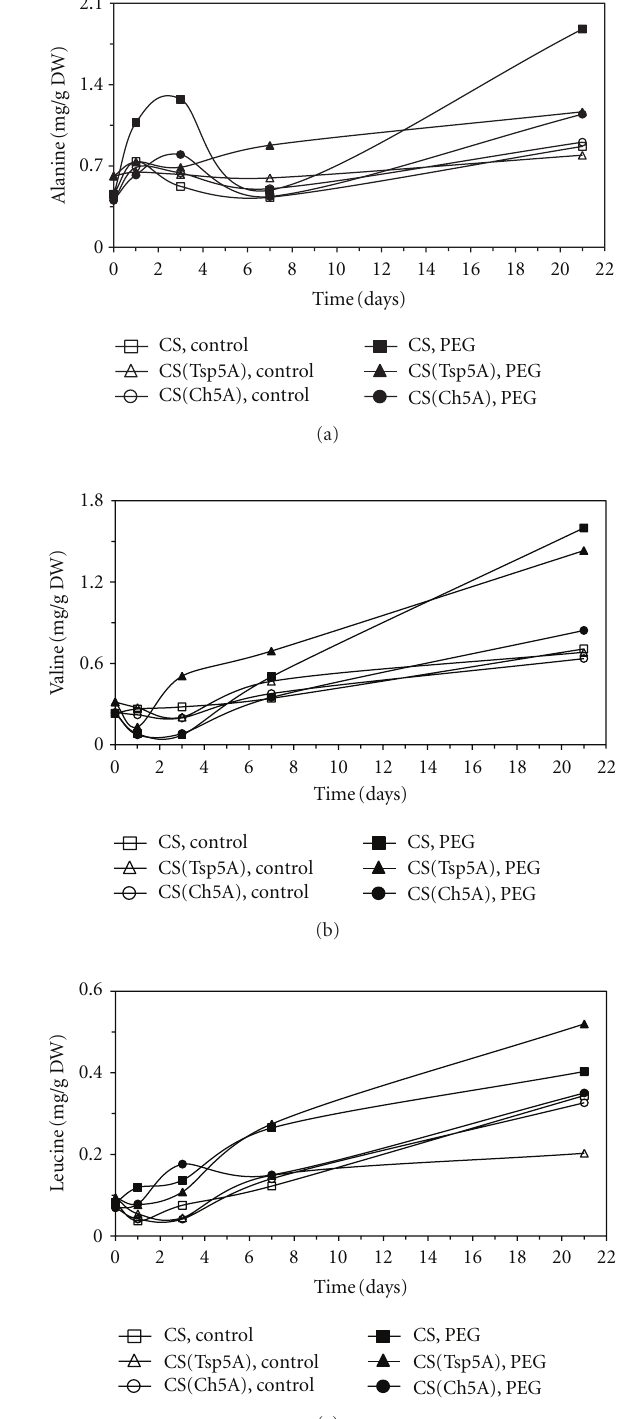
Figure 7: E ff ect of osmotic stress on the concentration of amino acids belonging to the pyruvate family. The time course of changes was compared under control and stress (15% PEG) conditions in the freezing-sensitive CS and CS(Tsp5A) and the freezing-tolerant CS(Ch5A) wheat genotypes. The standard deviations of the data were below 10% in each case (not shown on the graphs because of the better transparency). (a): Ala (SD: 0.261), (b): Val (SD: 0.146), and (c): Leu (SD: